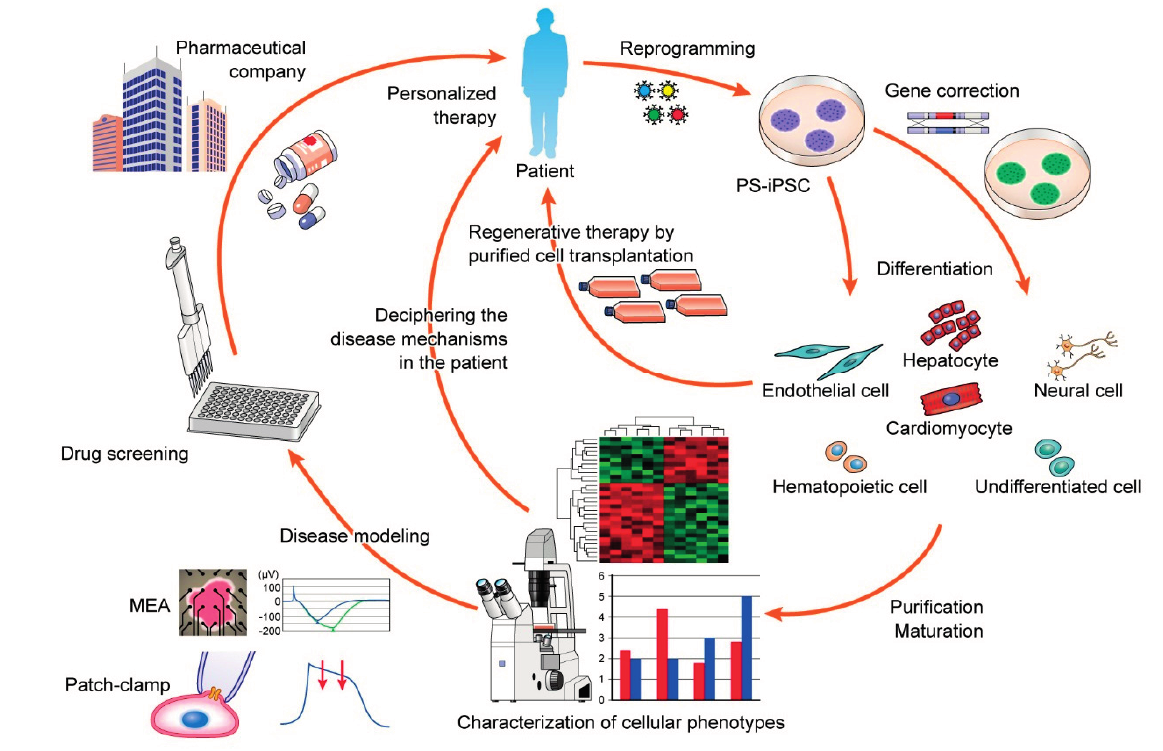
Figure 1. Flowchart of potential applications of patient-specific induced pluripotent stem cell (PS-iPSC) systems. Somatic cells derived from patients with genetic disorders are reprogrammed into a pluripotent state, that is, iPSCs, via induction of defined